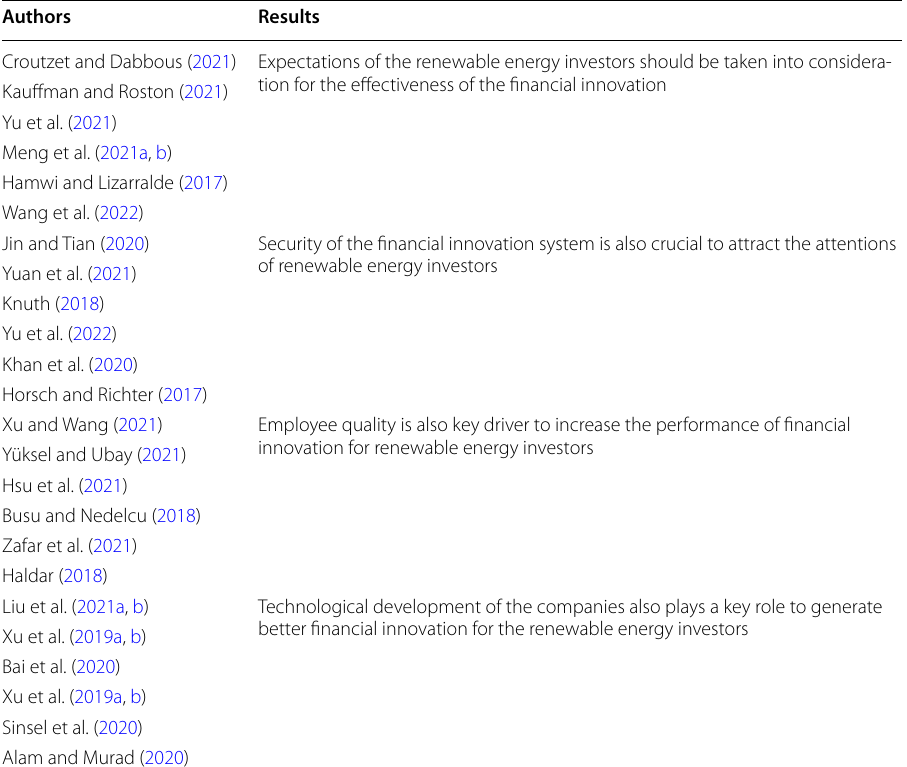
Table 13 Literature review summary